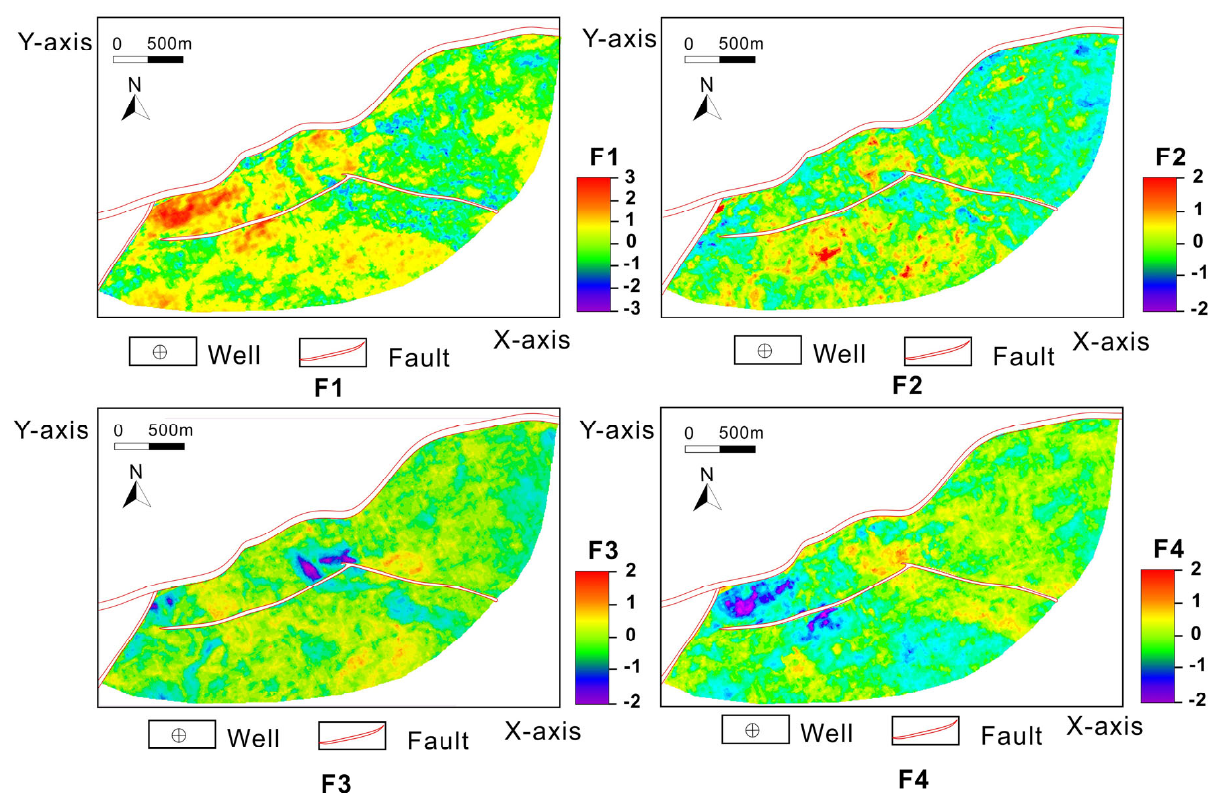
Figure 8. Spatial distributions of the four principal components.